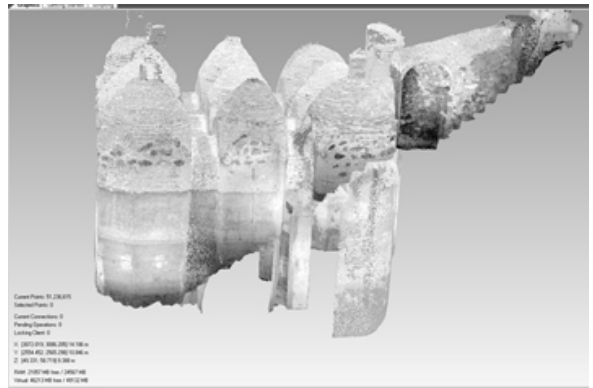
Figure 7. The mesh model from original point cloud